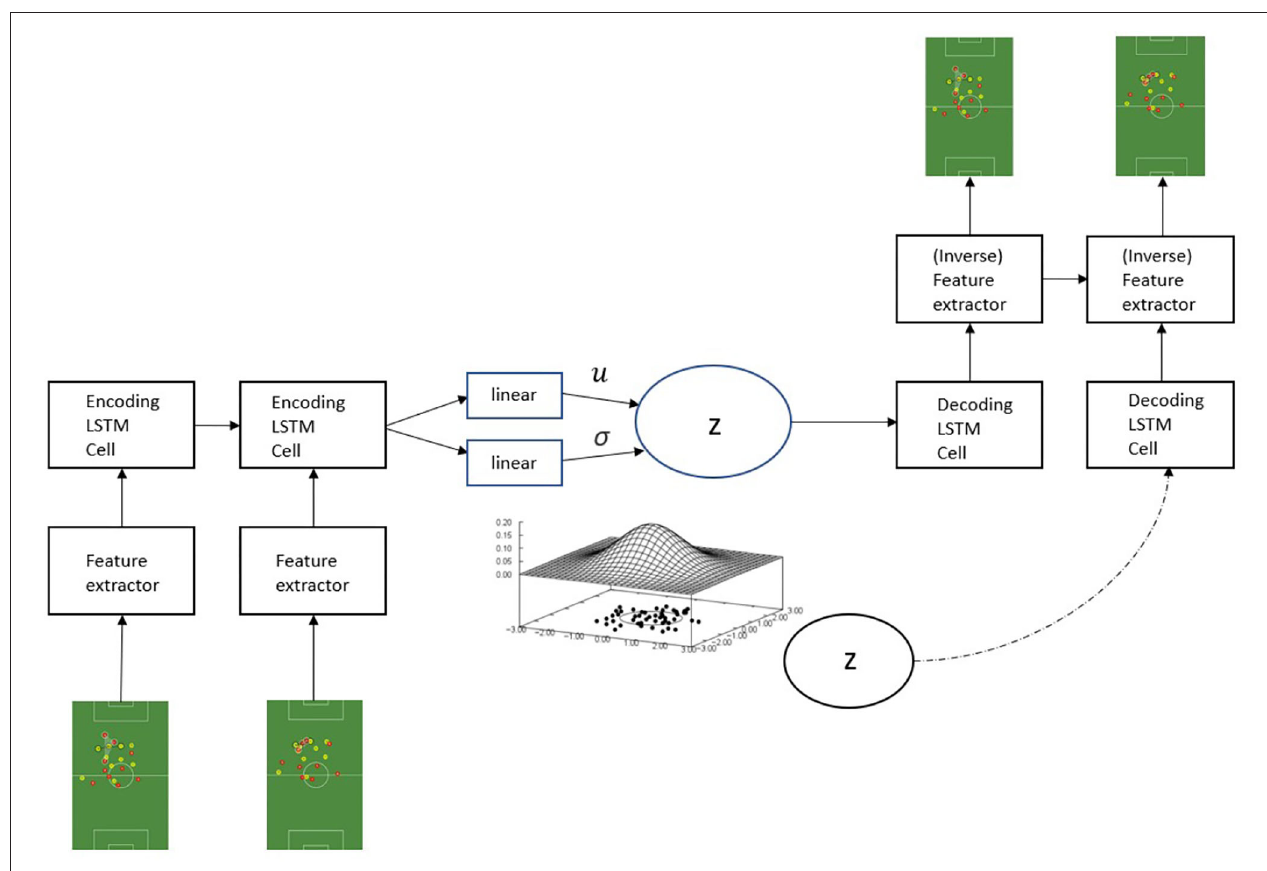
FIGURE 2 | The SeqSoccerVAE. The model takes a sequence of frames as input and then extracts corresponding feature representations per timestep, which are passed to an LSTM network that outputs a global summary of the sequence. The sampled latent representation is used to reconstruct the